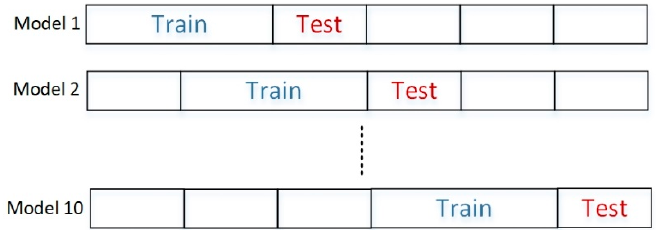
Figure 19. Sliding window train-test split for comparison of means.